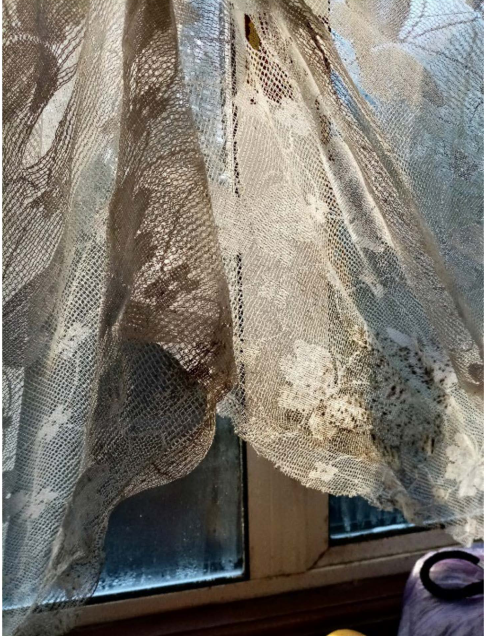
Figure 4. “Mould in the